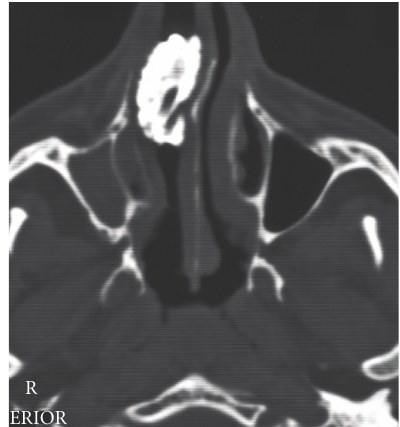
Figure 3: Axial CT scan showing the rhinolith in the right nasal cavity, with consecutive shadowing of the right maxillary